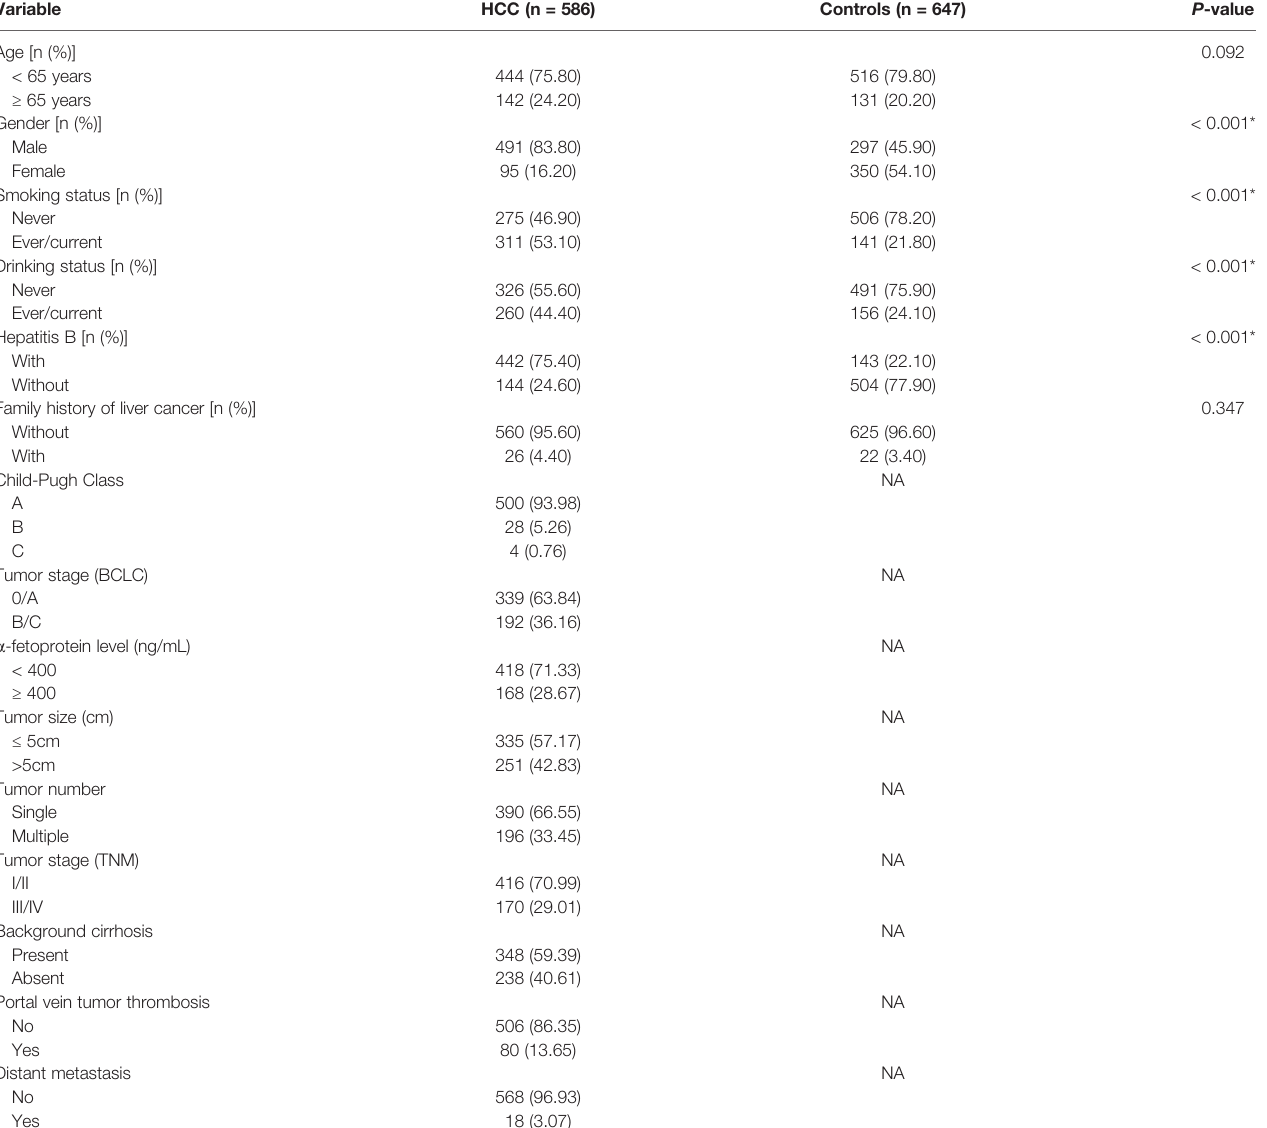
TABLE 1 | Baseline characteristics of HCC patients and controls.